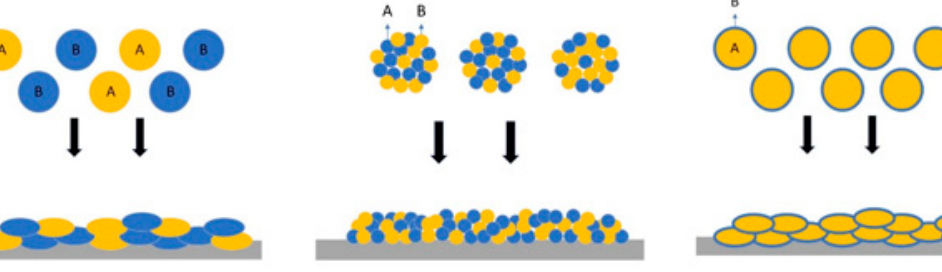
Figure 11. Microhardness distribution in the Al + Al 2 O 3 composite coating obtained by LPCS [126]. Reproduced with permission from [Archives of Civil and Mechanical Engineering], Elsevier, 2016.